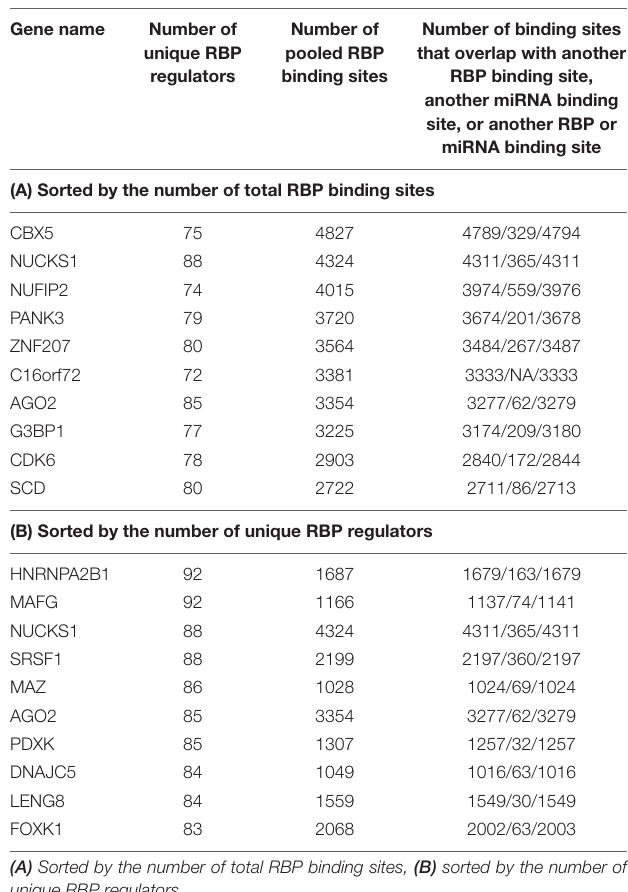
TABLE 2 | Human genes that have the highest number of RBP